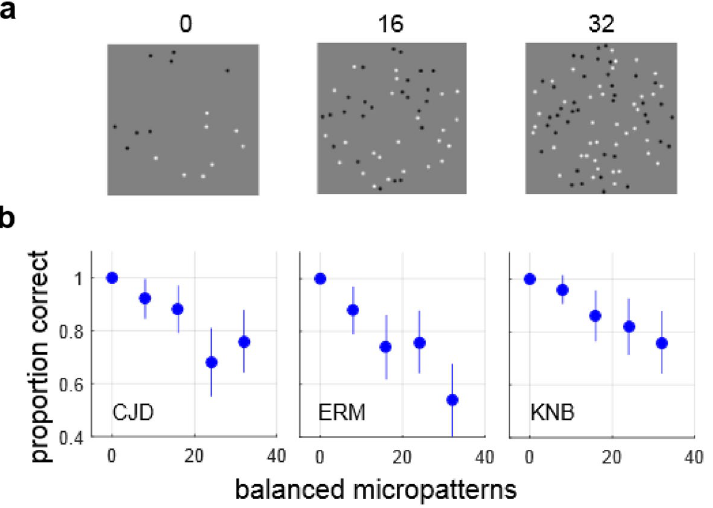
Figure 5. Holding luminance difference constant. ( a ) Examples of LTB stimuli used in Experiment 2, having an equal number (8) of unbalanced micropatterns on each side of the boundary, with varying numbers (0, 16, 32) of balanced micro-patterns. In this series, the luminance difference across the boundary is constant for all stimuli. ( b ) Proportion correct responses for three observers for differing numbers of balanced micropatterns. Lines indicate 95% binomial proportion confidence intervals for each level (N = 50 trials at each level). We see that performance degrades significantly with increasing numbers of balanced micropatterns, despite